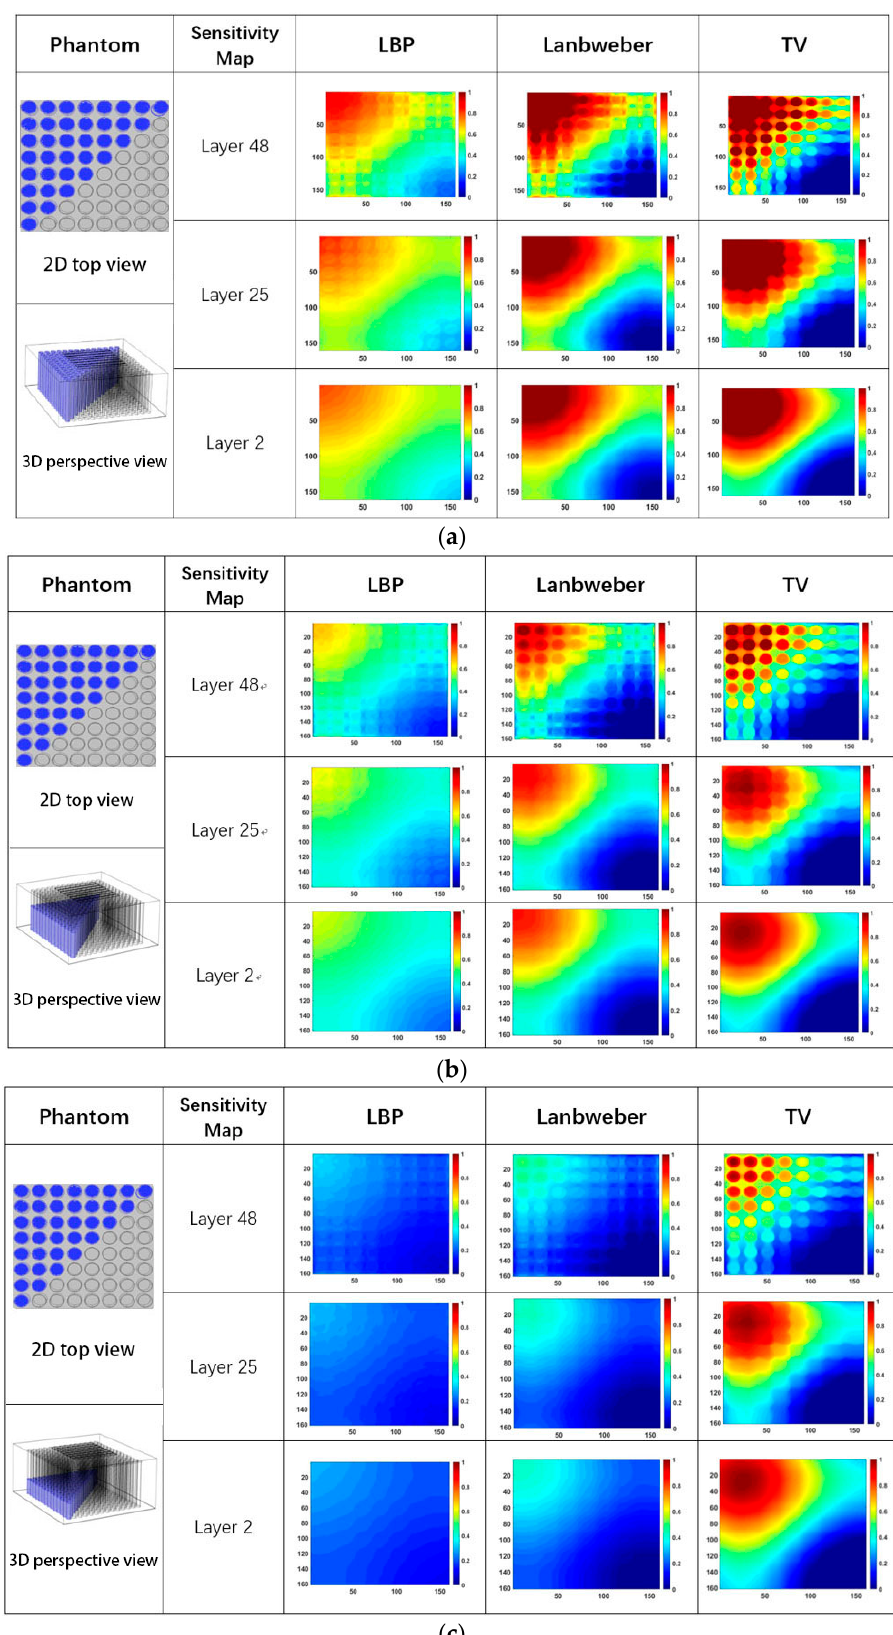
Figure 11. The imaging results while the column holes at the top left triangular region are full of different quantities of water, ( a ) 100% full of water, ( b ) 50% full of water, ( c ) 25% full of water.